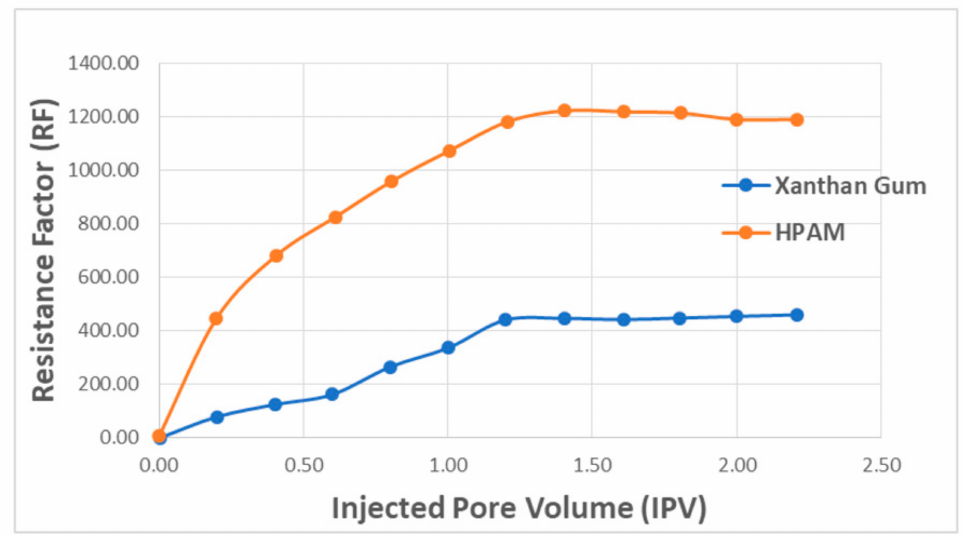
Figure 18. RF versus injected PV for both the polymers. Reprinted and modified from